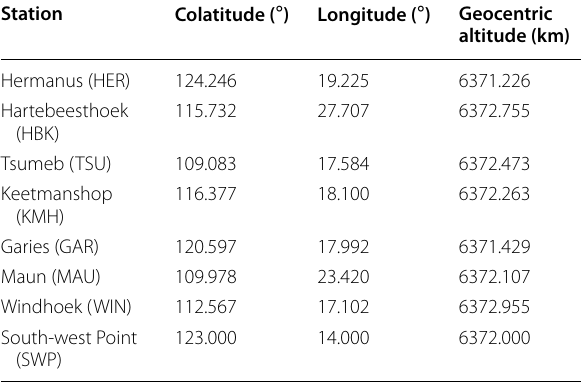
Table 1 Geocentric coordinates of the points that are used in the evaluation of the SACFM-2 model at ground